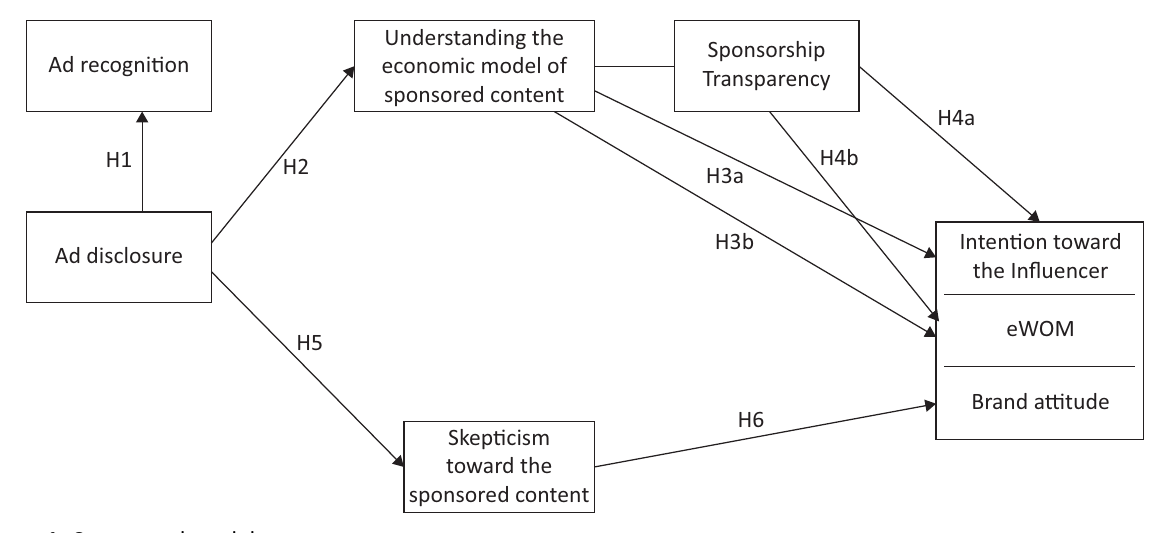
Figure 1. Conceptual